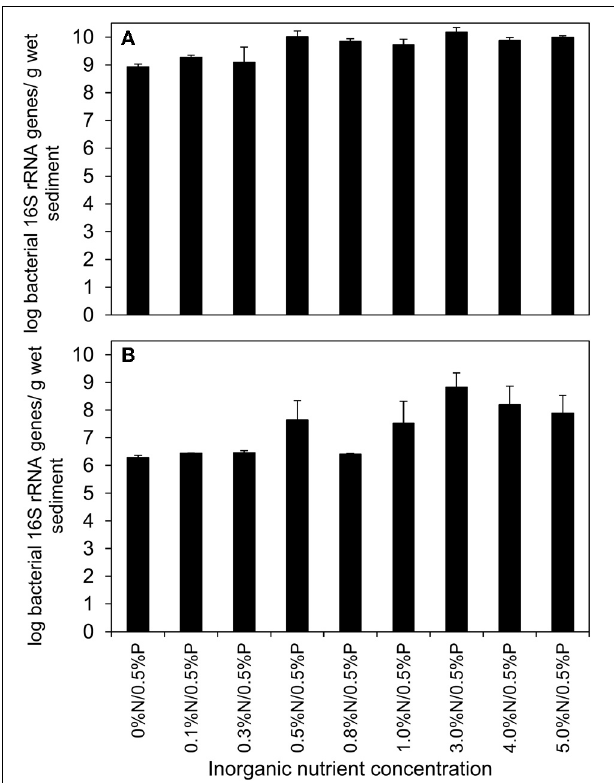
FIGURE 8 | qPCR analysis of total bacterial 16S rRNA genes (A) and Alcanivorax spp. 16S rRNA genes (B) from crude oil and nutrient treated beach microcosms incubated for 6 days. All microcosms were treated with 0.5% P w/w of oil and the values below the columns indicate the percentage of inorganic N added relative to the mass of oil. Each data point represents average value of three